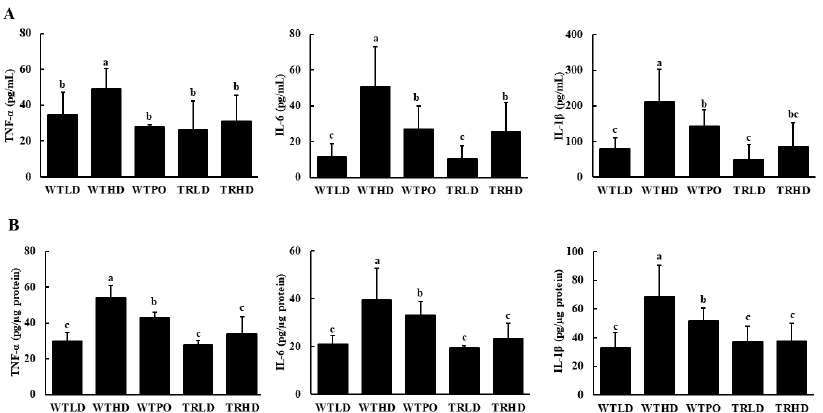
Figure 3. Pro-inflammatory cytokine levels in ( A ) serum and ( B ) colon. Mice were divided into five groups ( n = 8); WTLD and TRLD fed a low-fat diet (LD, 10% kcal from fat); WTHD and TRHD fed a high-fat diet (HD, 60% kcal from fat); WTPO fed an HD + PO diet (60% kcal from fat diet, supplemented with 8% perilla oil in the diet). Values are expressed as mean ± SD, and those with different superscript (a, b, c) letters indicate significance between groups by ANOVA with Duncan’s test at p < 0.05.